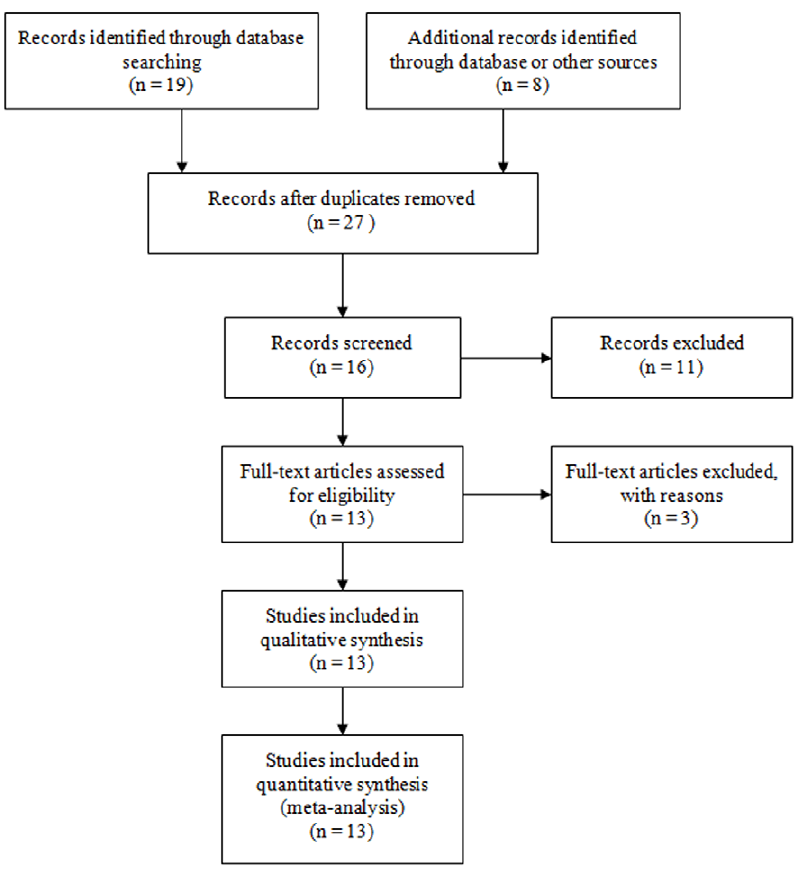
Figure 1. Flow diagram of studies identification.